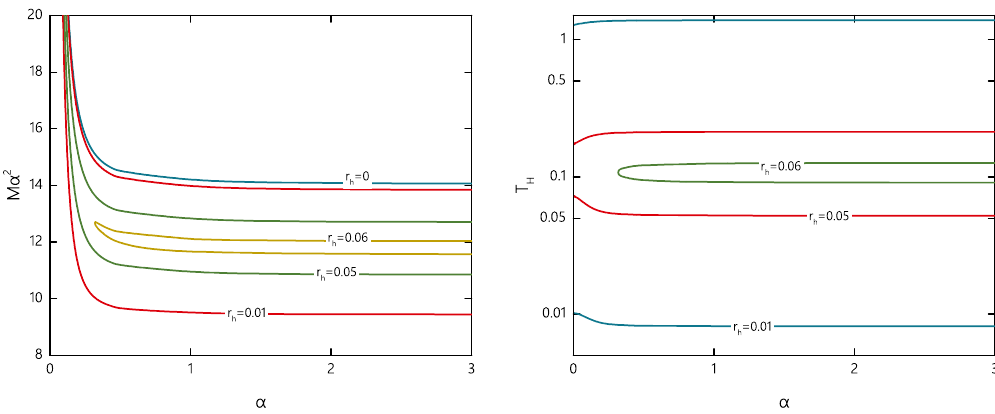
Figure 5 . Scaled ADM mass M(cid:11) 2 (left panel) and Hawking temperature T H (right panel) vs. the gravitational coupling constant (cid:11) , for a set of values of the horizon radius r h , for hairy BHs of the O(3) model with m = 1 and ! = 0 :